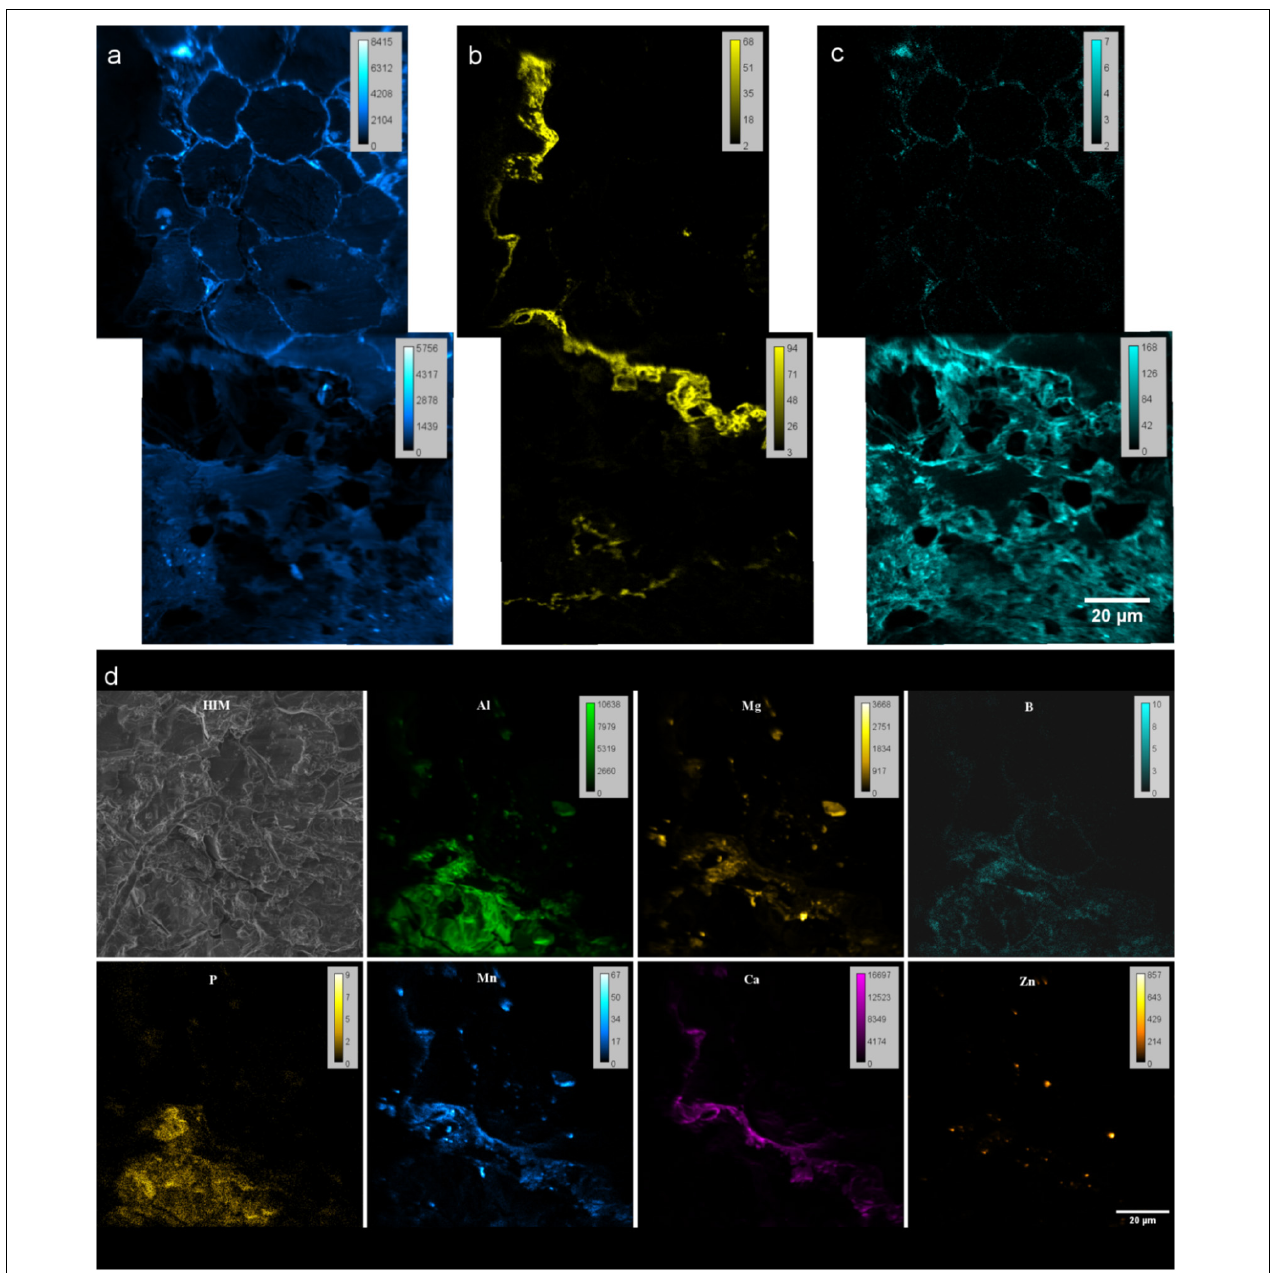
FIGURE 6 | NanoSIMS images of resin embedded Rhizosphere. (a–c) Spectra from negative extraction mode showing elemental distribution (a) 12 C 14 N − (b) 31 P 16 O x − and (c) 32 S − at root-soil interface of rhizosphere. Two FoV’s stitched by MosaicJ in Fiji. (d) Maps from positive extraction mode showing elemental distributions of 27 Al + , 24 Mg + , 11 B + , 31 P + , 55 Mn + , 40 Ca + and 64 Zn + . (d) Helium ion micrograph (HIM) of the analyzed area.